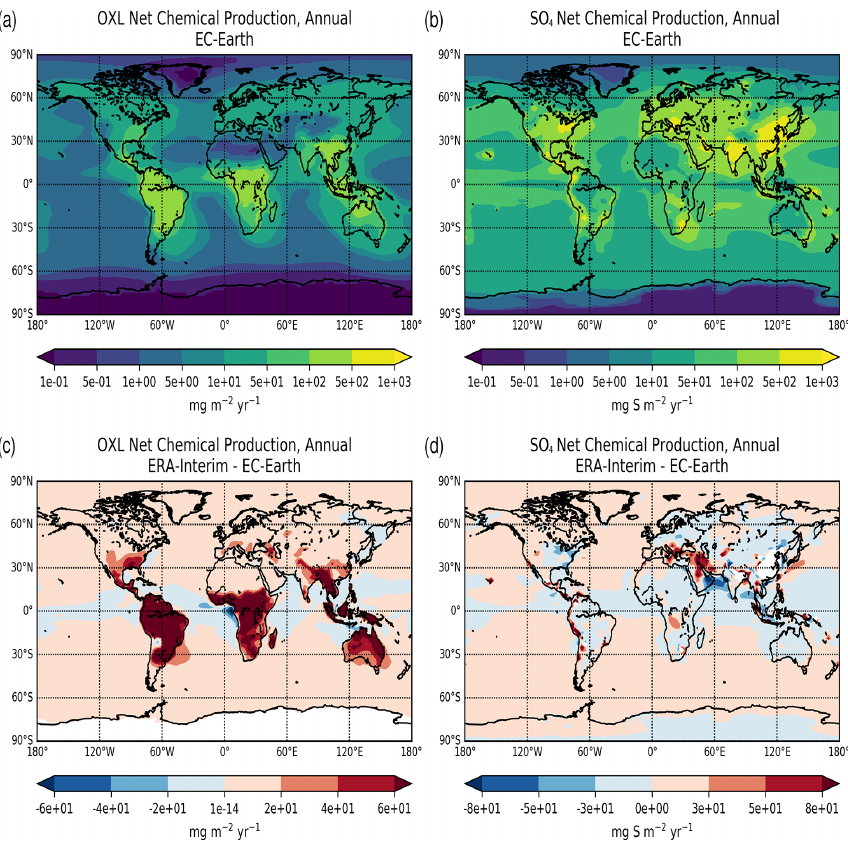
Figure 2. Annual mean net chemical production rates for (a) oxalate (mgm − 2 yr − 1 ) and (d) sulfate (mgSm − 2 yr − 1 ) as calculated for the EC-Earth simulation averaged for the period 2000–2014, and the respective absolute differences to the ERA-Interim simulation (c, d)